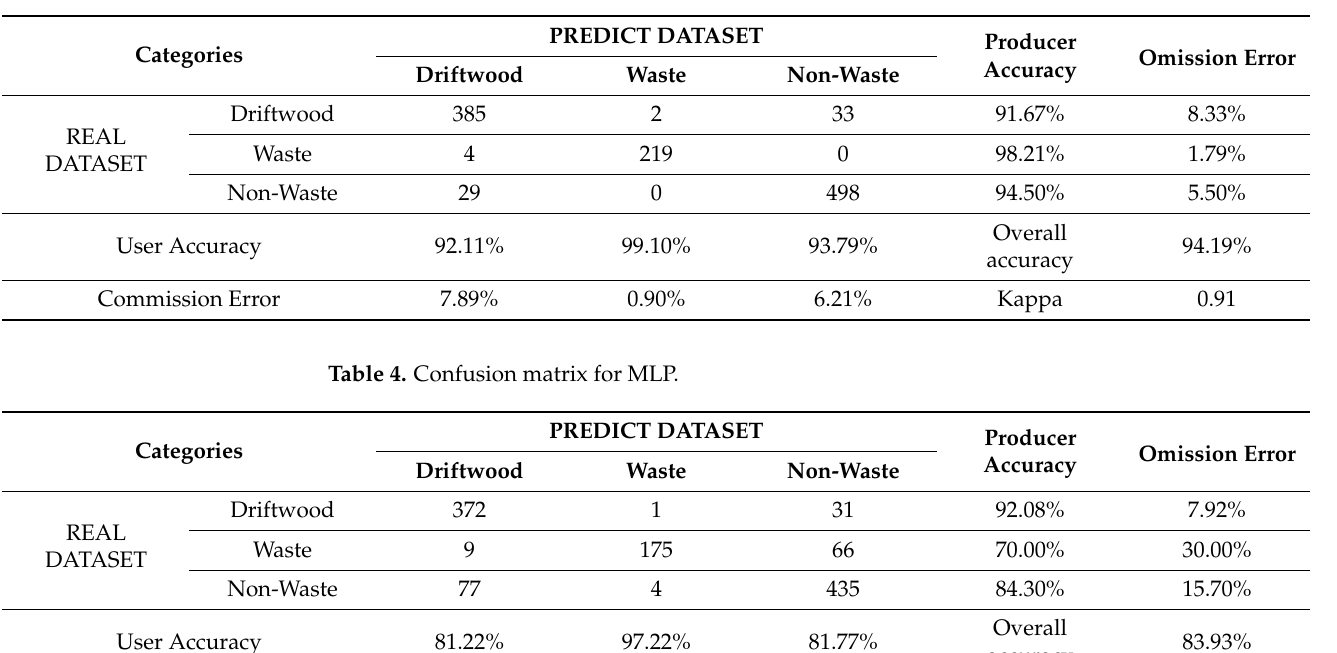
Table 3. Confusion matrix for AE + SVM.